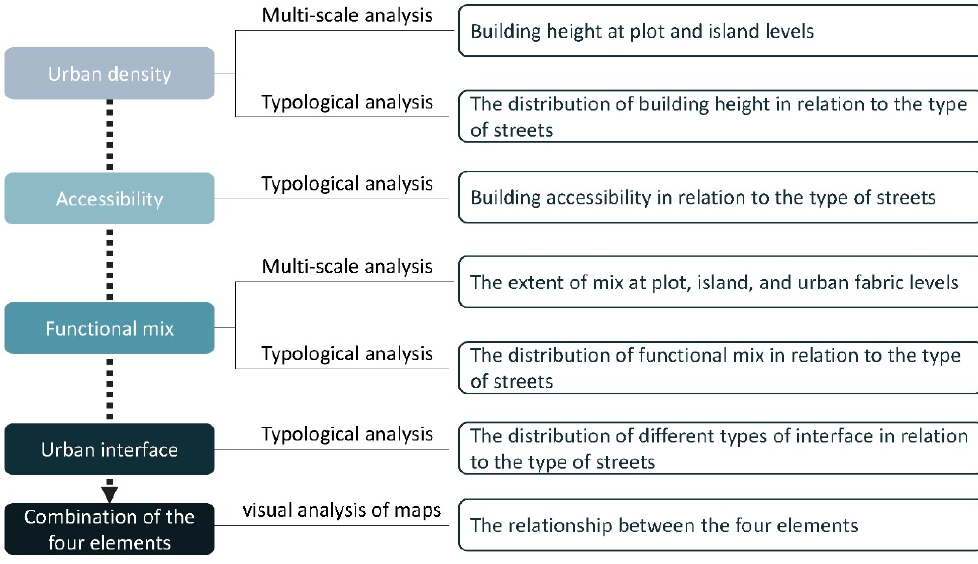
Figure 7. The process of data analysis.